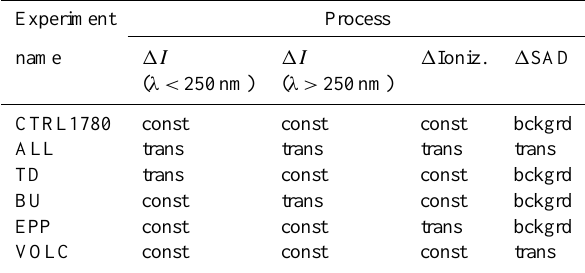
Table 2. Dalton minimum experiments: “const” denotes con- stant 1780 conditions. “bckgrd” denotes background aerosol emis- sions and volcanic emissions off. “trans” denotes transient forcing. “Ioniz.” stands for the parametrization for SPE, LEE and